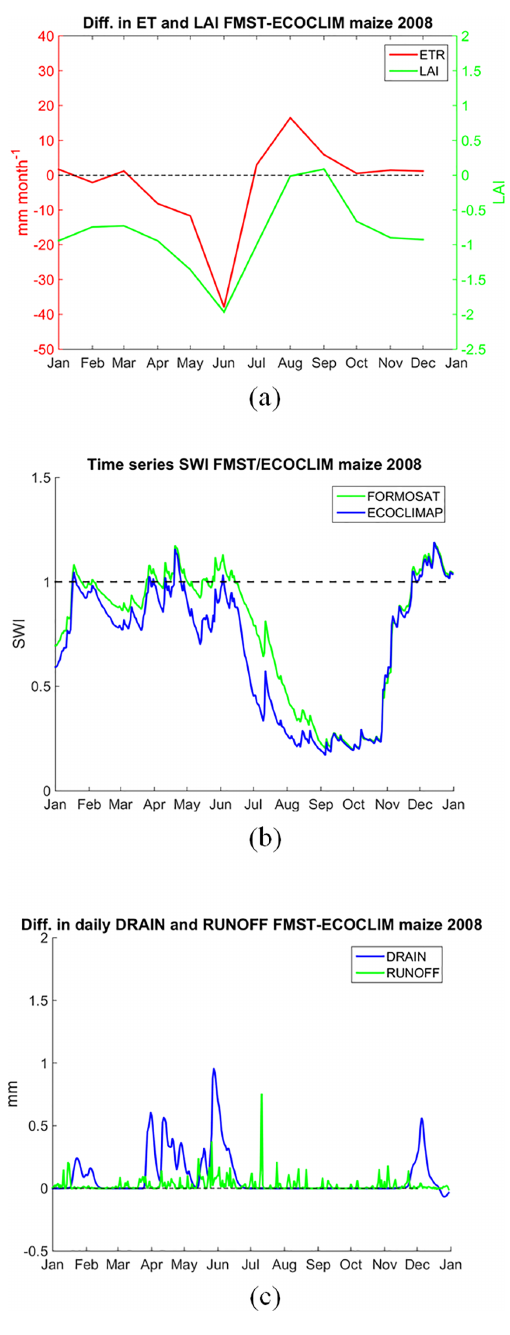
Figure 8. (a) Differences (diff.) in LAI (green) and evapo- transpiration (red) between the two experiments (FORMOSAT- ECOCLIMAP), (b) time series of SWI, and (c) differences in drainage (blue) and runoff (green) values. Averaged across C 4 crops for